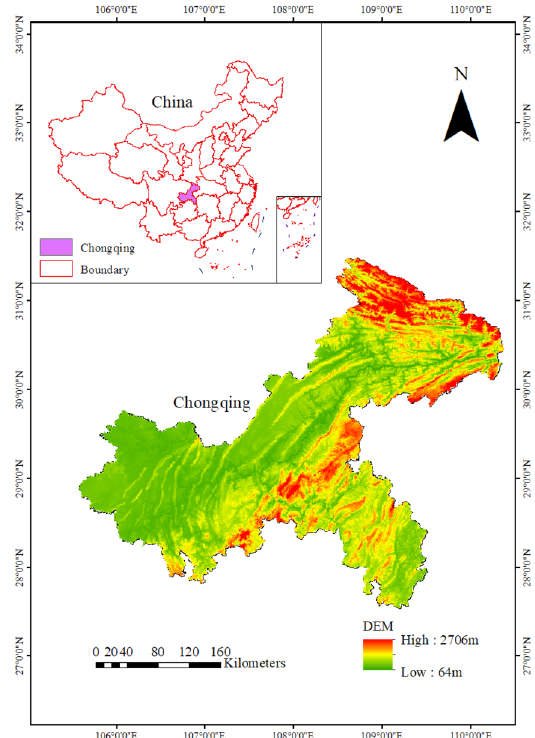
Figure 1. Location of the study area.